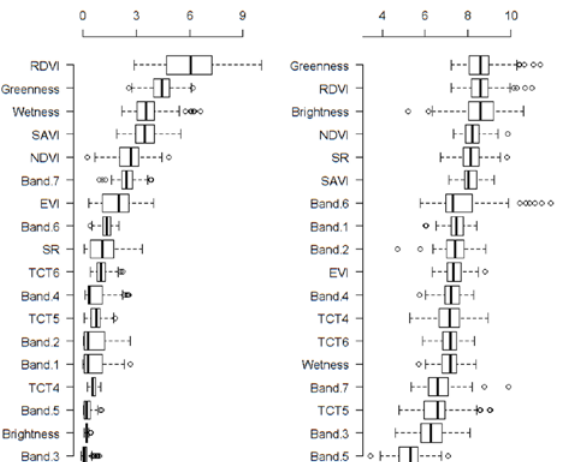
Figure 4: Variable importance of SPAD model cforest (left) rforest